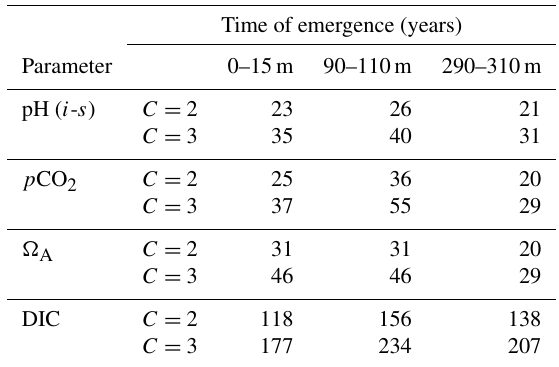
Table A2. Calculated times of emergence of carbonate system pa- rameters at various depths, rounded to the closest year. The C value represents the threshold used (2 or 3 standard deviations of annual